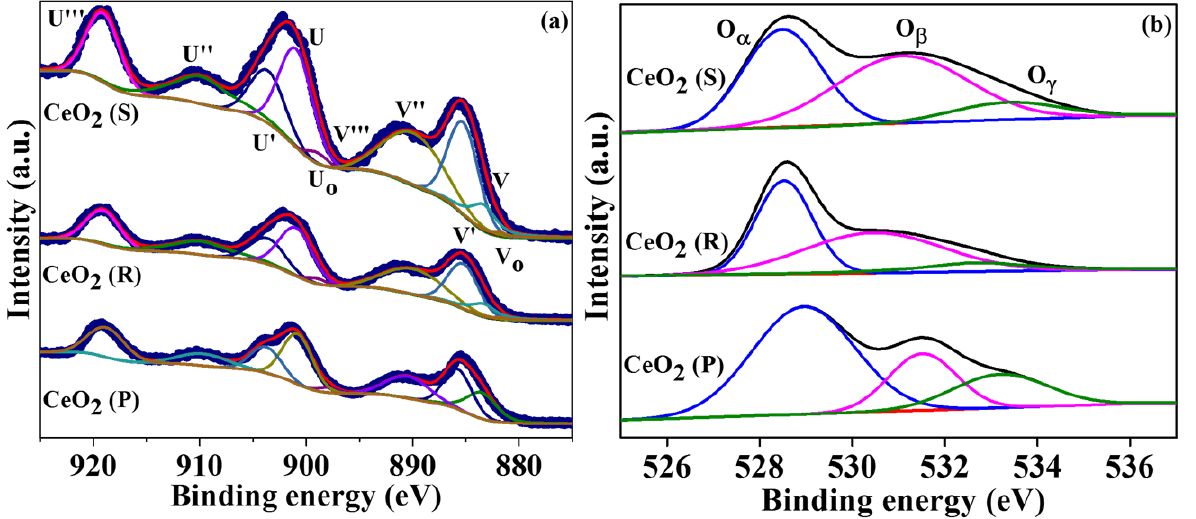
Figure 5. XPS spectra of ( a ) Ce (3d) and ( b ) O (1s) of CeO 2 (S), CeO 2 (R) and CeO 2 (P).